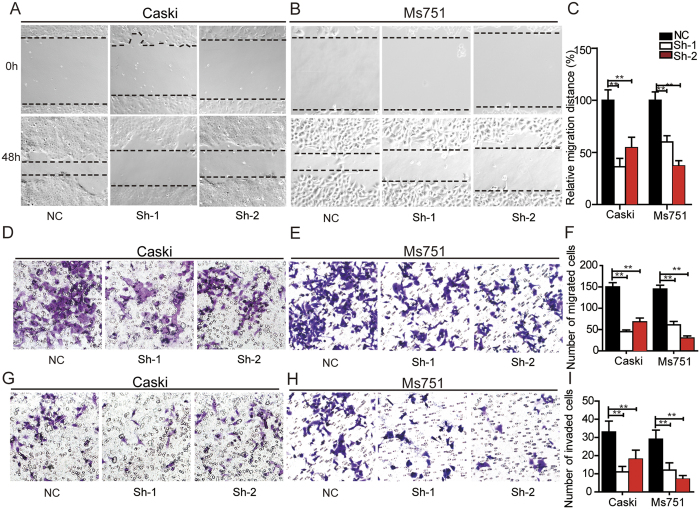
Silencing of CTHRC1 suppresses cervical cancer migration and invasion in vitro.(A and B) Representative wound healing images of Caski (A) and Ms751 (B) at 0 and 48 h, respectively. The black line outlined the cell boundary. (C) Quantification of wound healing rates was analyzed in Caski and Ms751 cells respectively. Data are means ± SD of the wound area relative to the Nc group, n = 3. (D and E) Representative migration images of CTHRC1 silenced and Nc cells. (F) Quantification of migration rates was analyzed in Caski and Ms751cells respectively. (G and H) Representative invasion images of CTHRC1 silenced and Nc cells. (I) Quantification of invasion rates was analyzed in cells. Original magnification: 200 × . Quantifications of cells on the lower surface of the membrane were performed with three randomly selected fields. Data are means ± SD. *P < 0.05, **P < 0.01.